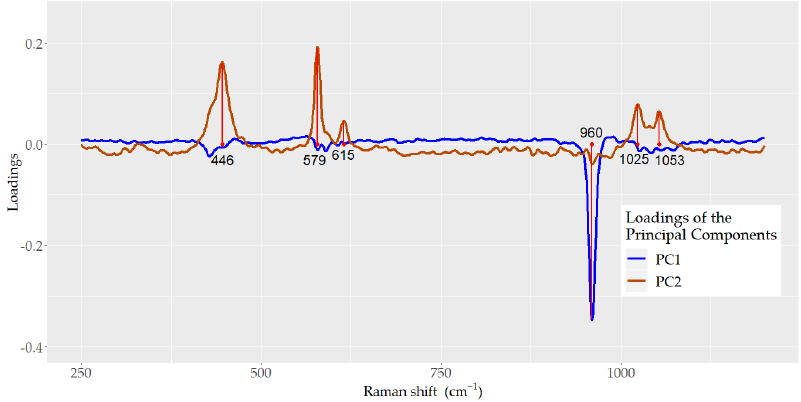
Figure 5. Principal component analysis (PCA). Loadings plot of principal component 1 (PC1) and principal component 2 (PC2) of the Raman spectra data.